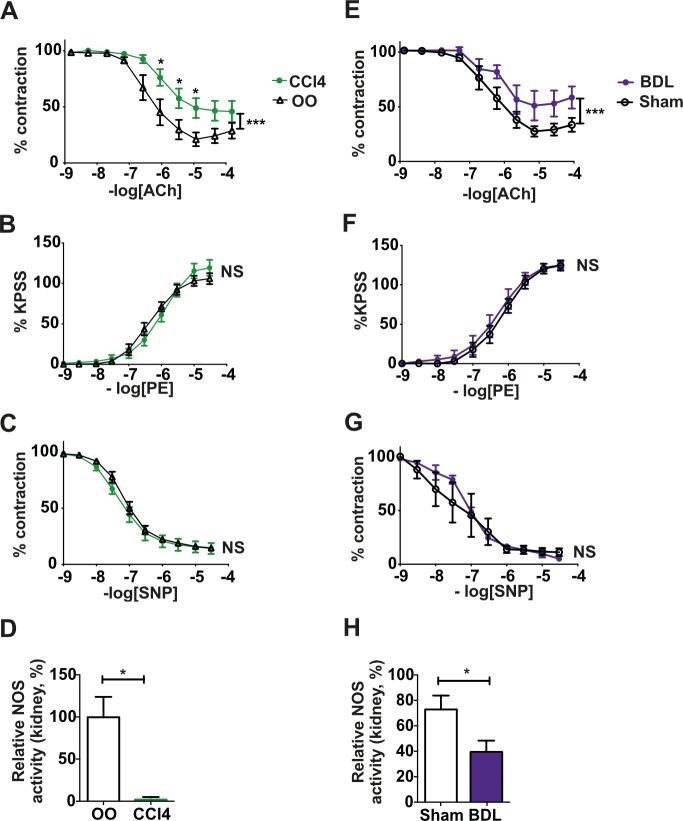
Vascular responses in isolated extrarenal renal arteries from cirrhotic rats.Concentration–response curves to acetylcholine (ACh; A and E), phenylephrine (PE; B and F), and sodium nitroprusside (SNP; C and G) in isolated extrarenal renal arteries from 16-wk CCl4 and 4-wk bile duct ligation (BDL) rats (n = 8–12). Data presented as mean ± standard error of the mean (SEM), relative to preconstricted value, analyzed by two-way ANOVA with post hoc Bonferroni correction (*p < 0.05; ***p < 0.001; NS, not significant). Nitric oxide synthase (NOS) activity in whole kidney extracts from 16-wk CCl4 (D) and 4-wk BDL (H) rats (n = 6–7). Data presented as mean ± SEM, analyzed by unpaired t-test (*p < 0.05). OO, olive oil.